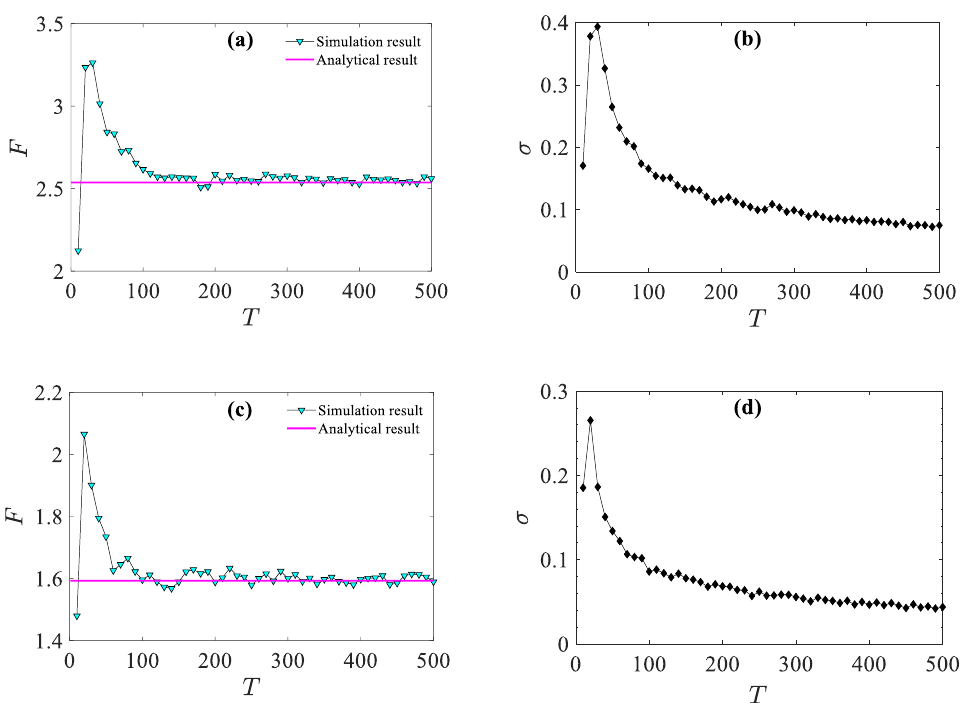
Figure 18. Dependence of output steady-state amplitude and MSE on total simulation time ( a , b ) ∆ 2 = 0.1, ( c , d ) ∆ 2 =